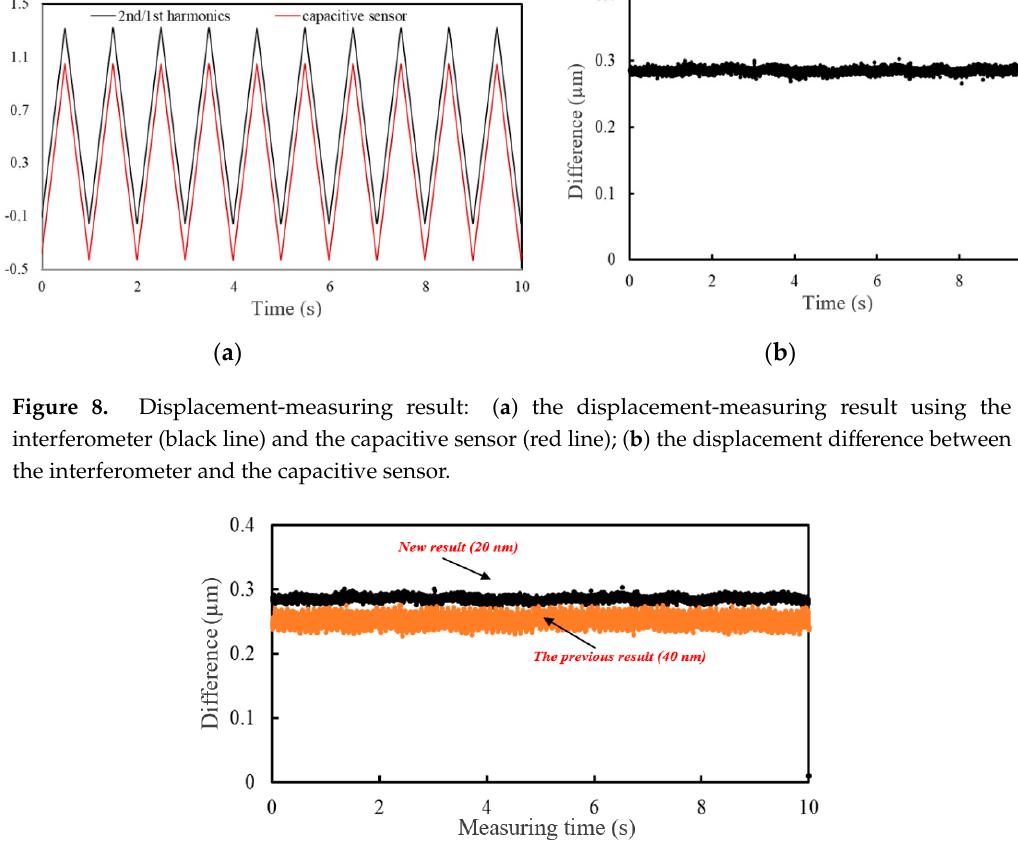
Figure 9. The difference in the displacement measuring result between the new system and our previous one.